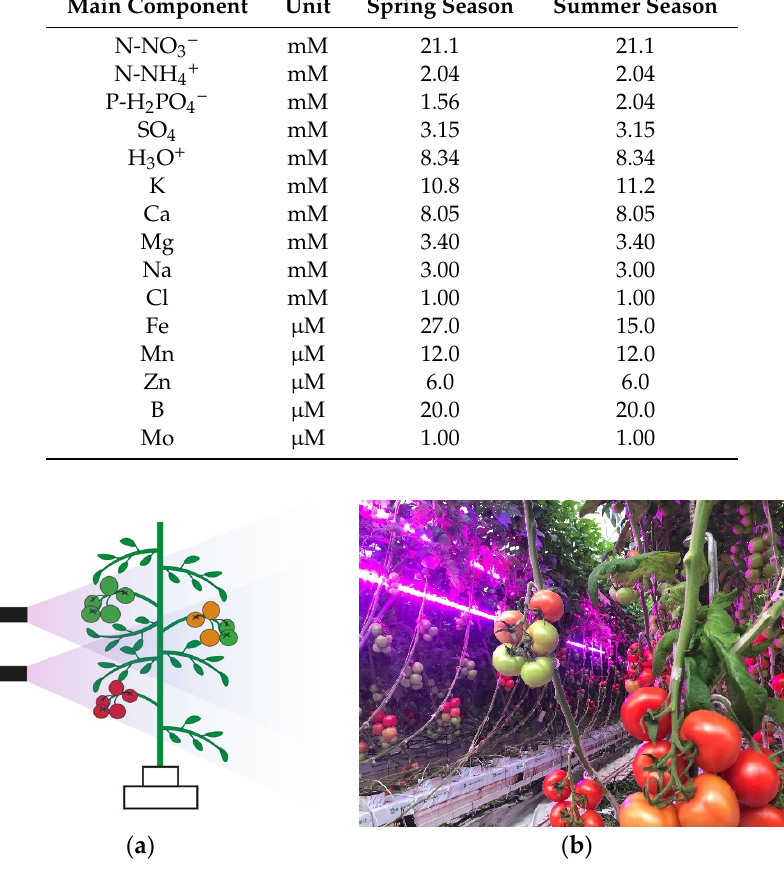
Figure 1. Supplemental light–emitting diode (LED) interlighting arrangement within plant canopy. ( a ) Graphical representation and ( b ) side ‐ view of the illuminated treatment on 3 May, 2019 (Photo: I. Paucek).